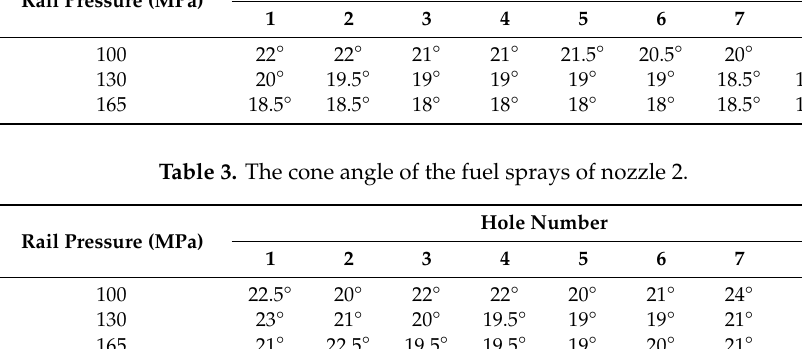
Table 3. The cone angle of the fuel sprays of nozzle 2.